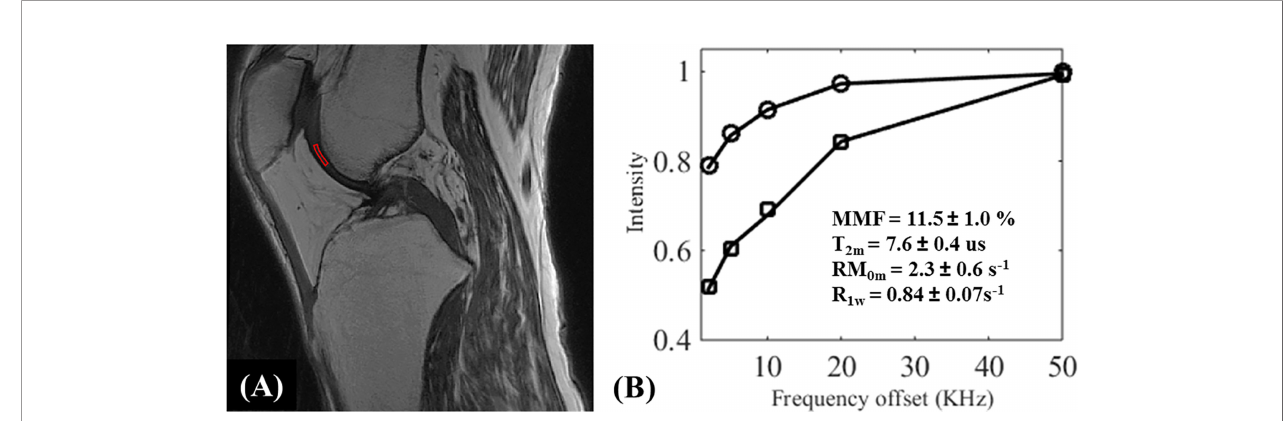
FIGURE 11 | UTE-MT modeling ( fi tting) of knee cartilage. The UTE ‐ Cones ‐ MT (A) images were acquired from an ex vivo knee joint specimen with two different MT fl ip angles of 500° and 1500° at fi ve different frequency offsets of 2, 5, 10, 20, and 50 KHz, and a region of interest (ROI) in the femoral condyle cartilage was selected for MT modeling. Image (B) illustrates the fi tting curve and corresponding fi tted parameters [i.e., MMF (%), T 2m (us), RM 0m (s -1 ), and R 1w (s -1 )]. MMF = macromolecular fraction; T 2m = T 2 relaxation time of macromolecular pool; R 1w = spin-lattice relaxation rate of water pool; RM 0m = proton exchange rate from water to macromolecular